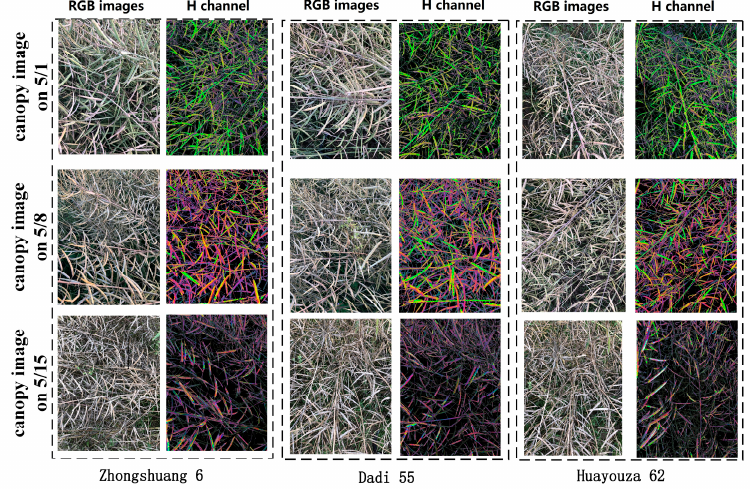
Figure 3. Images color changes during the mature period.